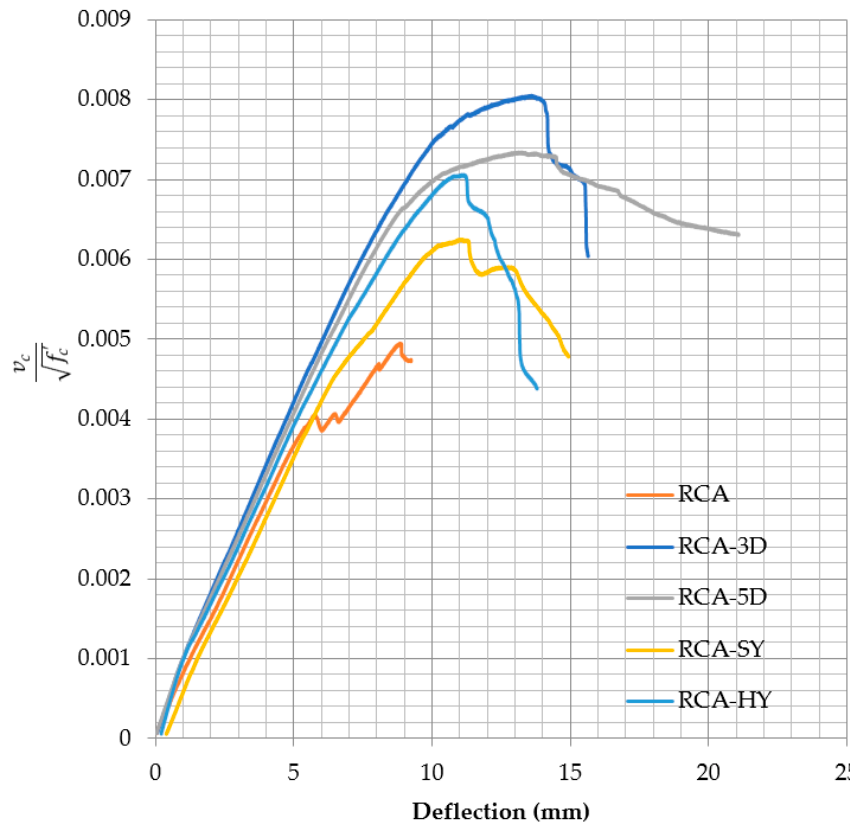
Figure 15. Normalized shear resistance vs Deflection.